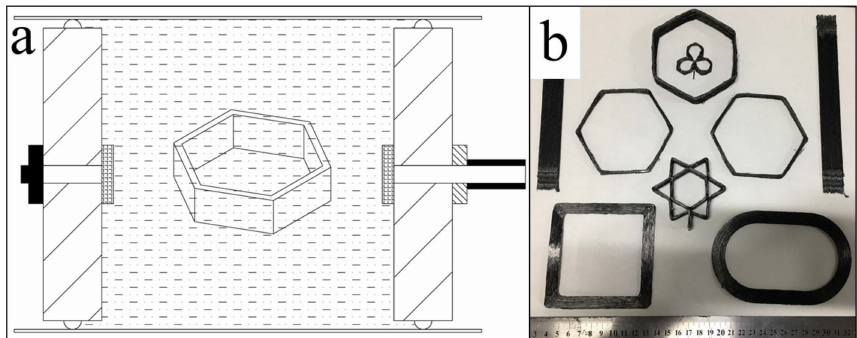
Figure 5. Curing module: ( a ) a schematic illustration of the curing process and ( b ) the cured CFRTPC